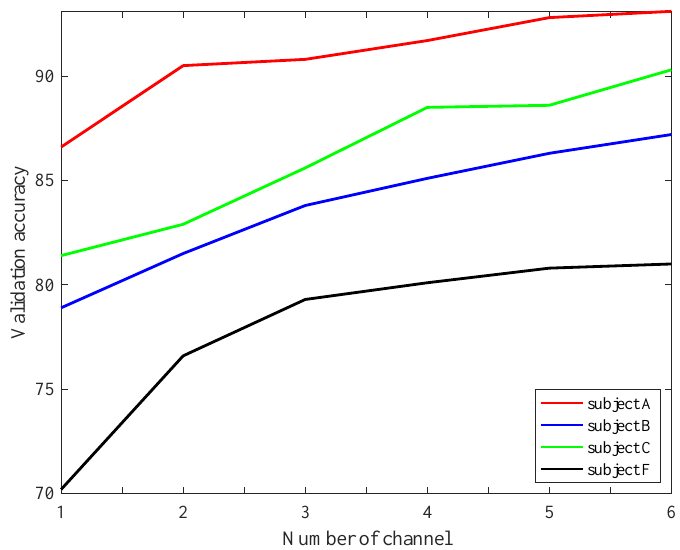
Figure 4. Accuracy as a function of the number of channels per